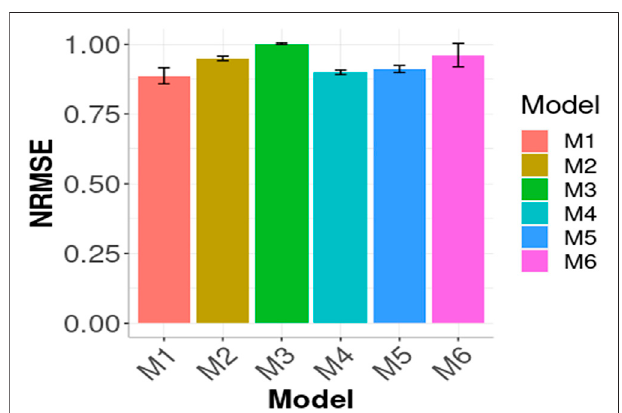
FIGURE 4 | Prediction performance in terms of Normalized Root Mean Squared Error of the six models (M1, M2, M3, M4, M5, M6) across environments (Global) in Maize data. M1 denotes the generalized boosted machine model, M2 denotes the generalized linear model, M3 denotes the support vector machine model, M4 denotes the random forest model, M5 denotes the Bayesian regression model and M6 denotes the deep neural networks model.